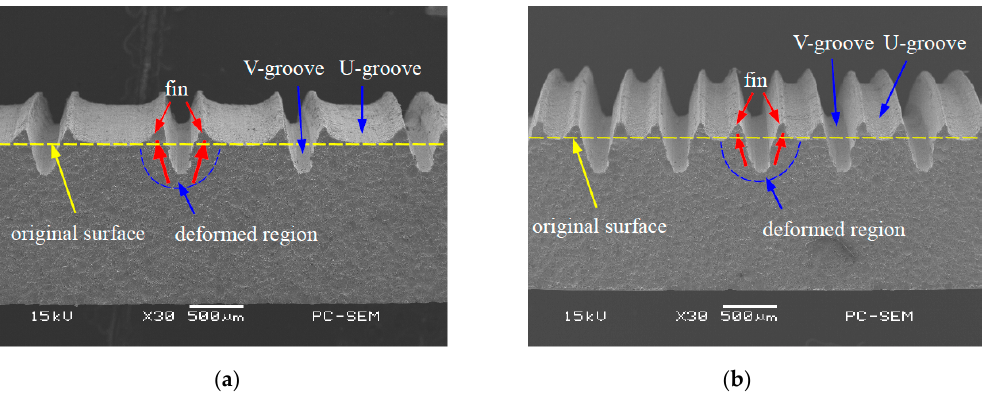
Figure 5. Mixed structures of V-grooves and U-grooves by P-E processing. ( a ) d ph = 0.80 mm, a ph = 0.20 mm; ( b ) d ph = 0.40 mm, a ph = 0.20